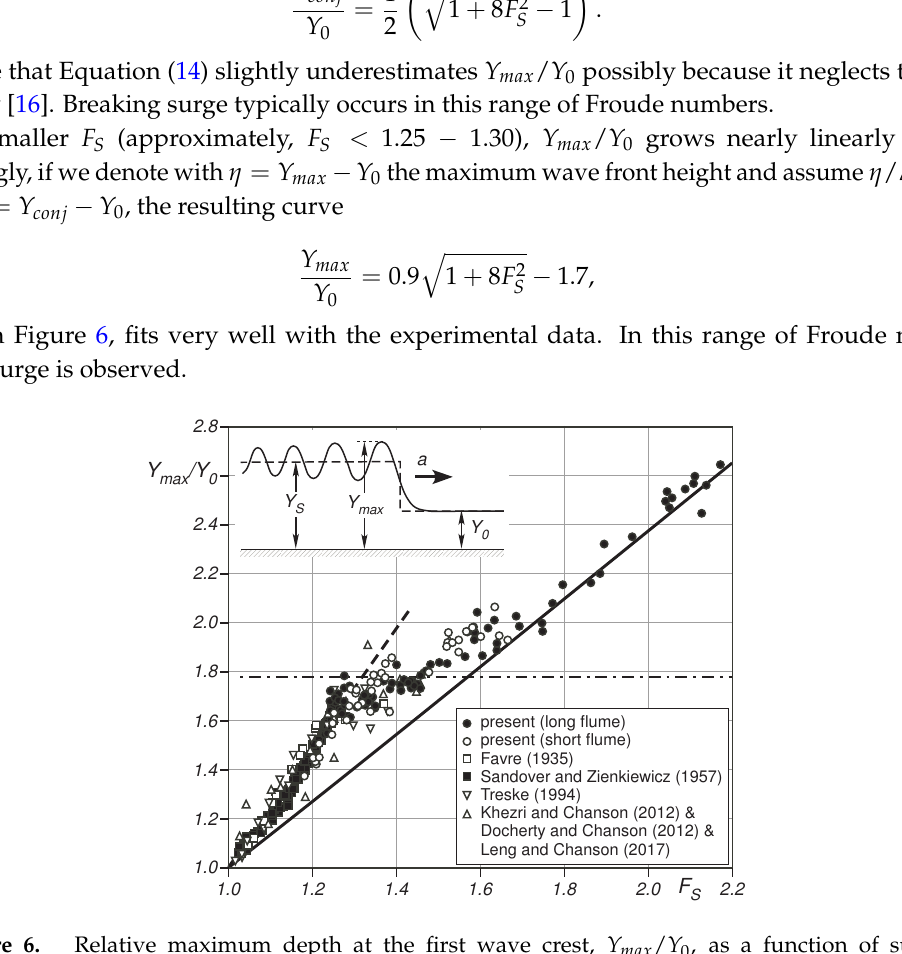
Relative maximum depth at the first wave crest, Y max / Y 0 , as a function of surge Froude number, F S . The black curve denotes the conjugate depths ratio as given by Equation (14); the dashed curve is from Equation (15), the dot-dashed line denotes the breaking criterion for a solitary wave ( Y max − Y 0 ) / Y 0 =